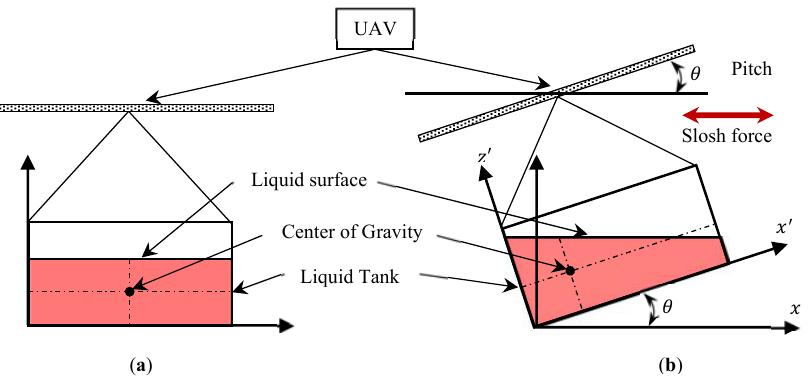
Figure 12. UAV tank’s center of gravity changes: ( a ) stable liquid’s center of gravity and no slosh force; ( b ) changing pitch-angle changes the CG and creates slosh force.